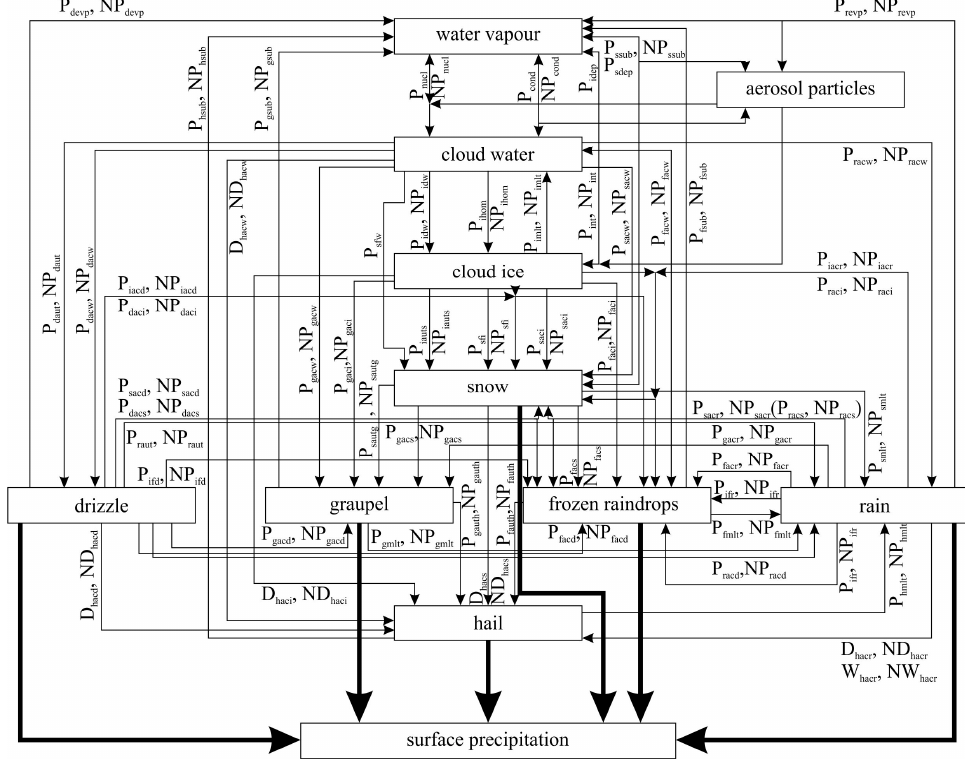
Figure 2. Flow-chart showing all types of hydrometeors and the microphysical processes through which they originate and grow in the model we used in the experiment. P XY and NP XY depict the mass production rate and number concentration for corresponding microphysical process, respectively. Arrows show possible conversion directions. Bold arrows depict sedimentation of hydrometeors.